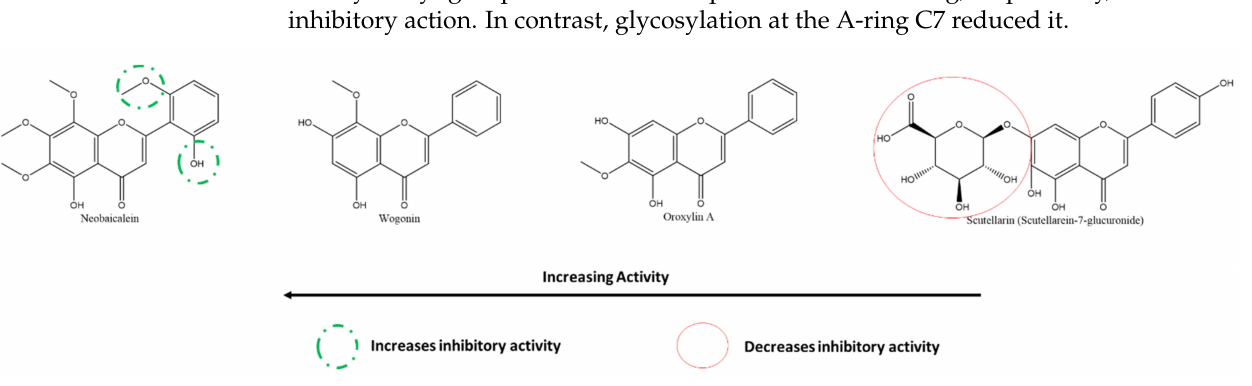
Figure 19. Structure–activity relationships of various flavones against SARS-CoV-2 S-ACE2 interaction, adapted from the experiments of [120] using cell-based in vitro FRET assays. Substitutions and groups that result in an increase/decrease in inhibitory activities are shown in red and green,